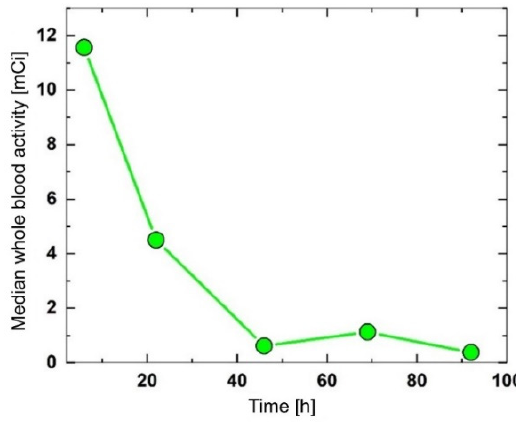
Figure 2. Blood activity curve as a function of time.